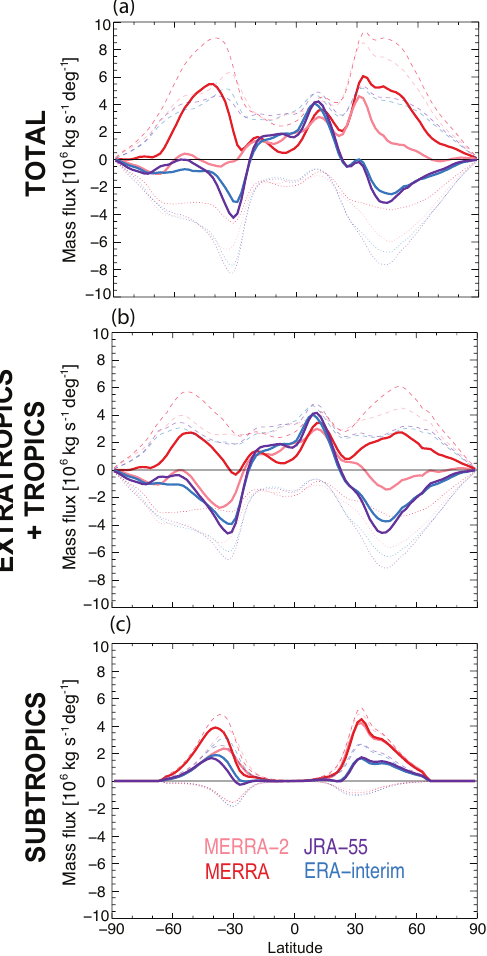
Figure 8. Annually and zonally averaged meridional distributions of STE from each reanalysis as a function of latitude and for (a) to- tal STE, (b) extratropical and tropical STE combined, and (c) sub- tropical STE. STT is shown as the dotted lines (negative), TST as the dashed lines (positive), and the net transport is given by the solid lines in each panel. STE from JRA-55 is shown by the purple lines, ERA-Interim by the blue lines, MERRA-2 by the light red lines, and MERRA by the dark red